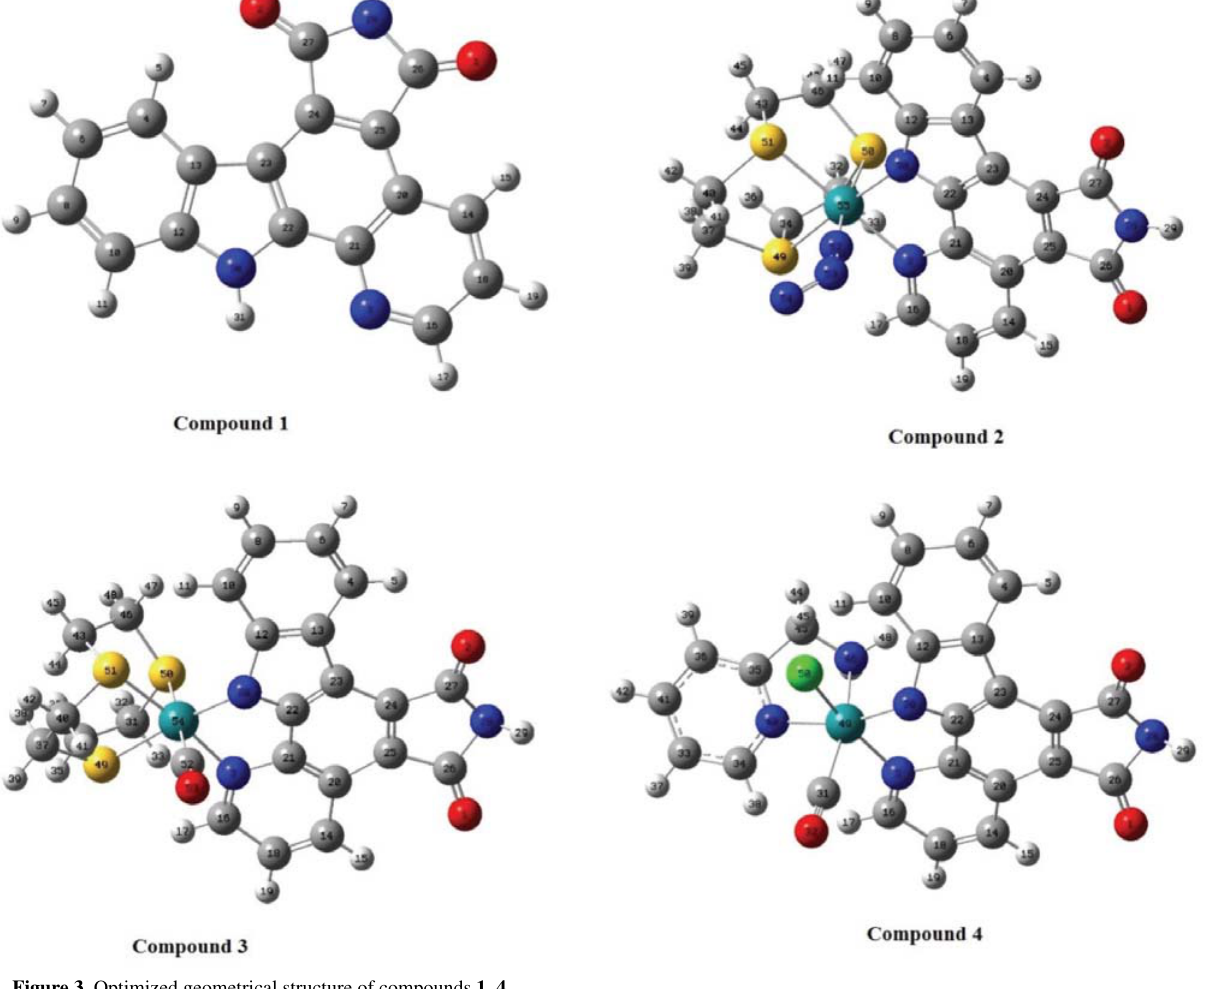
Figure 3. Optimized geometrical structure of compounds 1 – 4